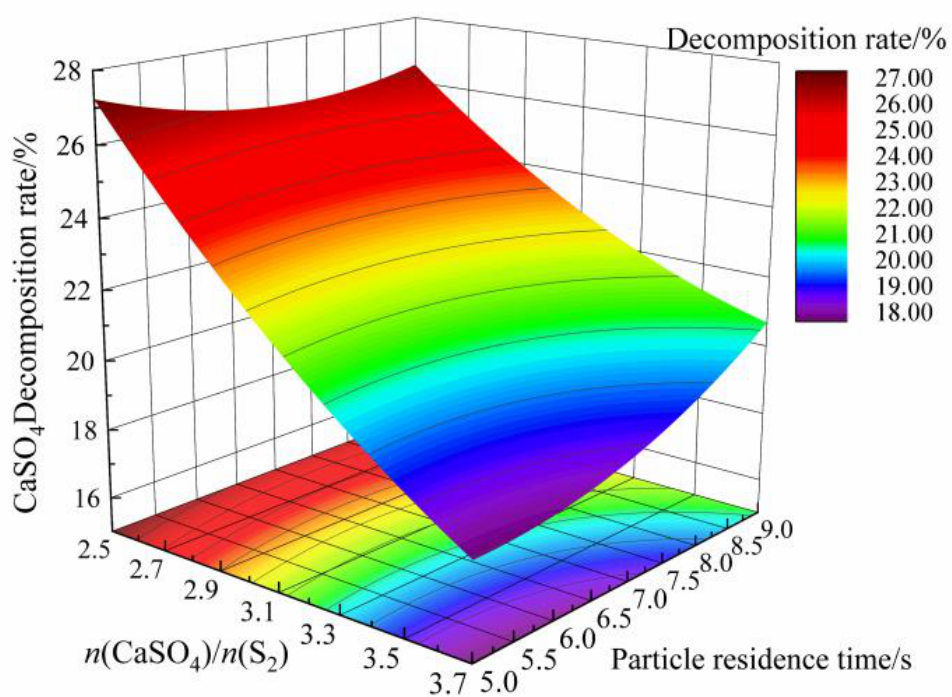
Figure 19. Effect of n (CaSO 4 )/ n (S 2 ) and particle residence time on decomposition rate of CaSO 4.